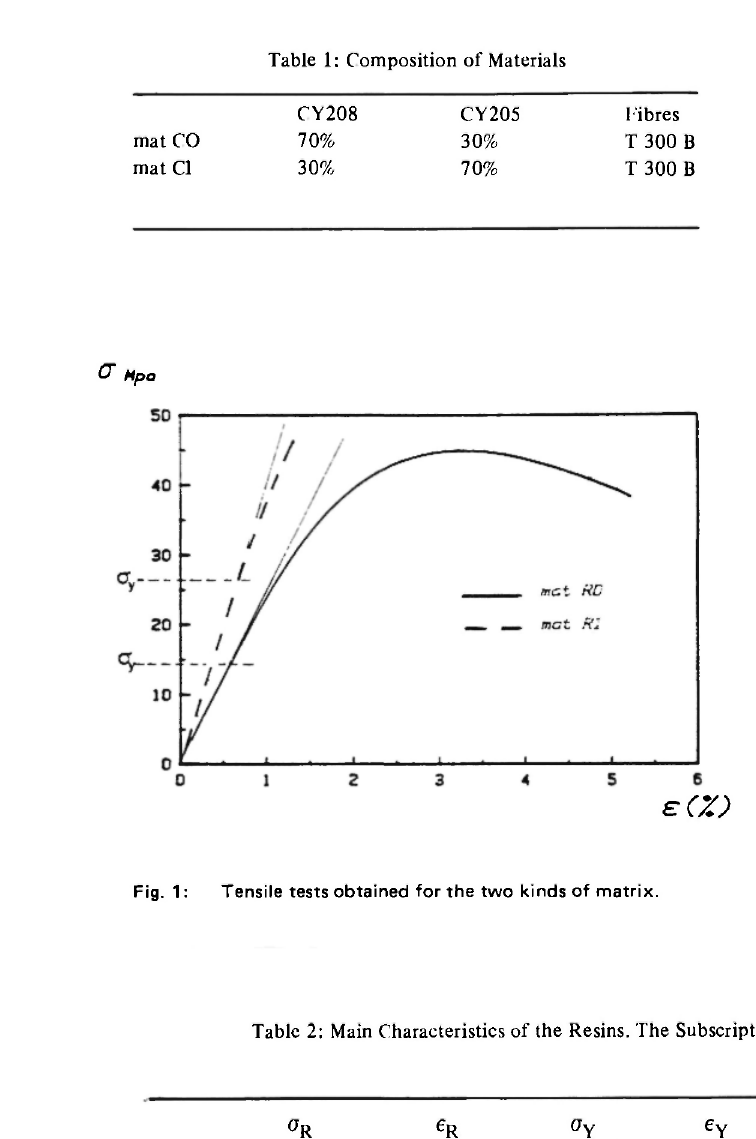
Table 2: Main Characteristics of the Resins. The Subscripts R and Y are for Failure and Plasticity, Respectively.